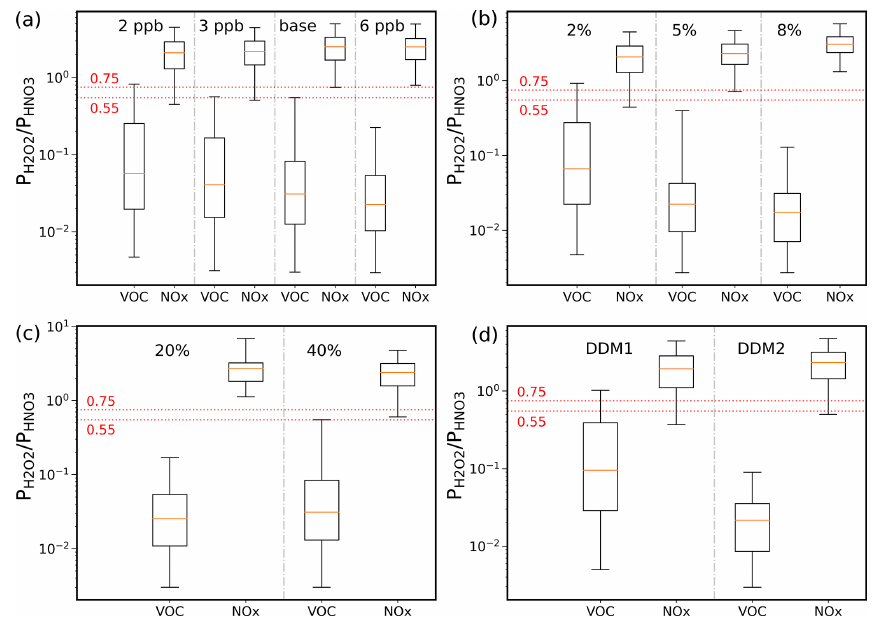
/P HNO values at the VOC- or NO x -limited grid cells with different setups in method- Figure 6. The percentile distributions of the P H 2 O 2 3 ology. The boxes indicate the 25th and 75th percentiles of the indicator values with the median values marked with horizontal red lines in the boxes, and the whiskers extend to the 5th and 95th percentiles. In each group, the upper whisker of the box in the VOCs column and the lower whisker of the box in the NO x column reflect the lower and upper values of the threshold intervals, respectively. The threshold intervals in Table 3 are indicated with dotted red